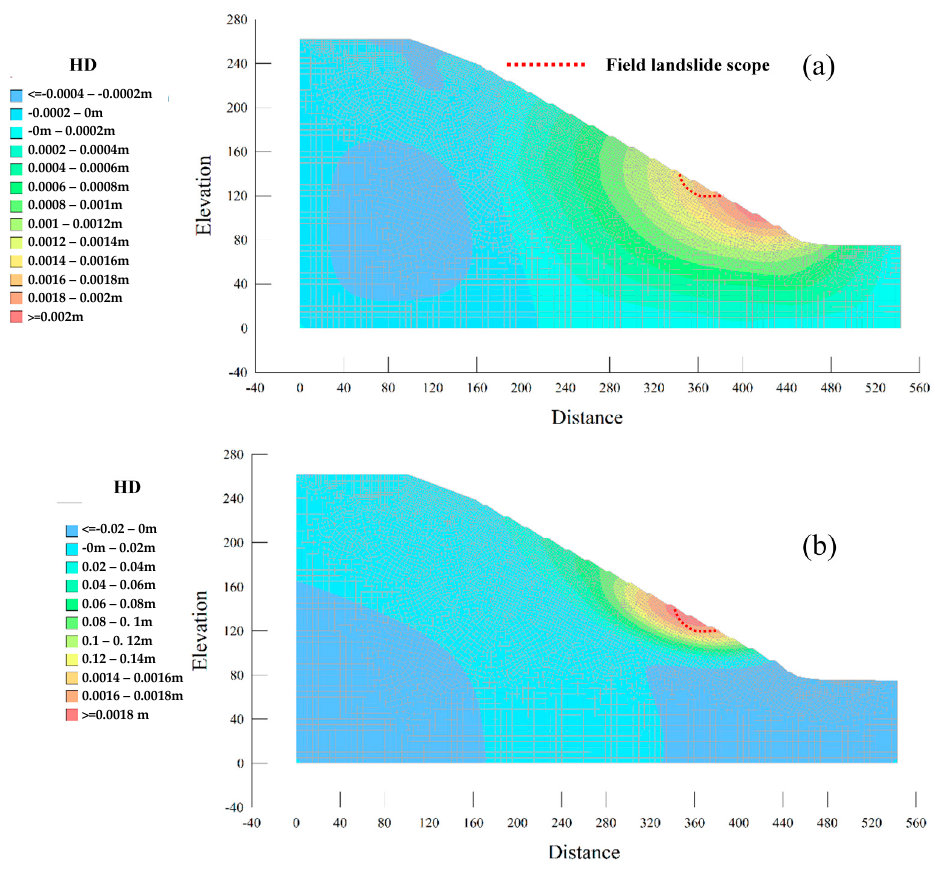
Figure 18. Cloud map of horizontal displacement of rock slope when landslide occurs (day 91): ( a ) Isotropic ( k r = 1); ( b ) k r = 0.01, β = 30 ◦ .